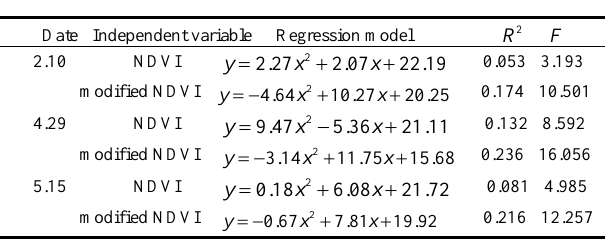
Table 6. 10cm soil moisture regression model in central Henan